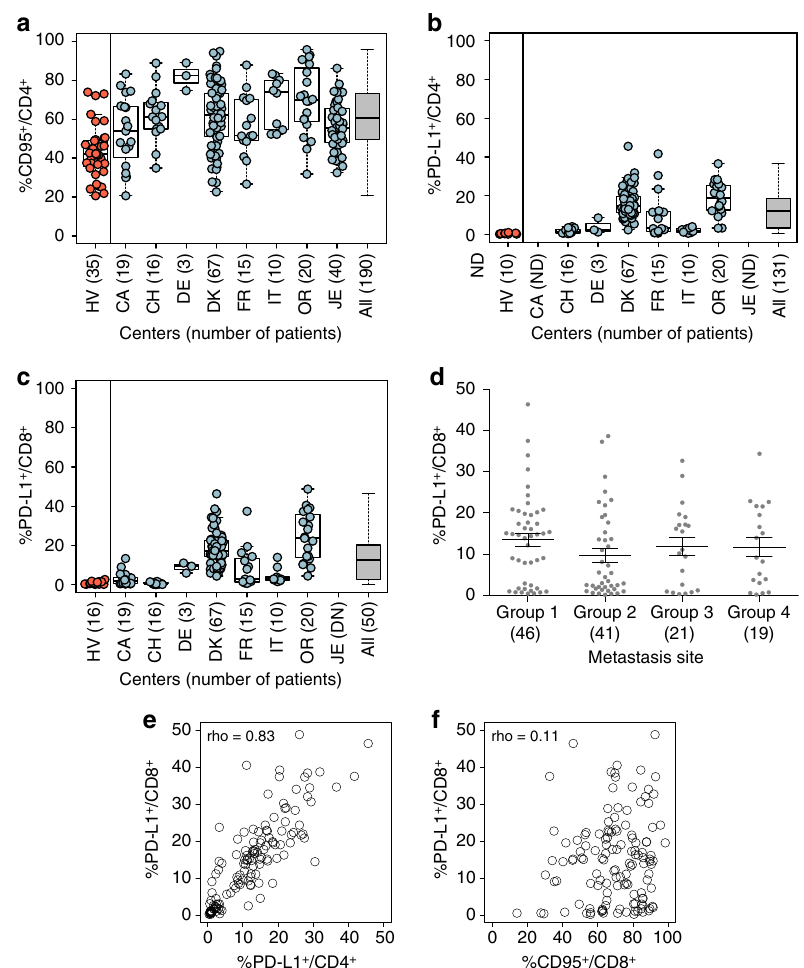
Fig. 4 Melanoma patients express higher levels of PD-L1 on circulating T cells than healthy volunteers. a − c Percentages of CD95 a and/or PD-L1 + b , c cells among blood CD4 + a , b or CD8 + c T cells, respectively, at baseline prior to ipilimumab. Flow cytometric assessments of the proportions of blood CD3 + CD4 + or CD8 + cells expressing PD-L1 after thawing in eight cohorts of MMel ( right columns ) except CA and/or JE (not assessed), as well as 10 – 35 healthy volunteers (in red , left column ). Each dot represents one healthy volunteer or patient. Mean and s.e.m. are represented along with the box plots for each cohort described in Supplementary Table 2. d Expression of PD-L1 on CD8 + T cells according to the metastatic sites: 1 (skin, lymph node and lung metastases only), 2 (visceral metastases, soft tissues +/ − group 1), 3 (bone metastases and+/ − groups 1 and/or 2) and 4 (brain metastases and others). e , f Spearman correlation between PD-L1 + /CD8 + and PD-L1 + /CD4 + or CD95 + /CD8 + with rho index; each dot representing one patient. Box and whiskers plots are represented from the corresponding distribution a − c . Mean + s.e.m.